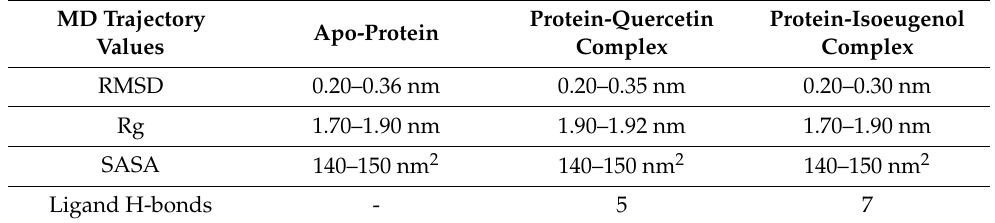
Figure 7. Analysis of RMSD, RMSF, Rg, SASA, and the number of hydrogen bonds of isoeugenol- (purple) and quercetin- bound (red) HAR complexes, as well as apo-protein α -glucosidase (green), at 100 ns. ( A ) Time evolution of RMSD values of both the complexes, along with the protein. ( B ) RMSF. ( C ) Radius of gyration (Rg). ( D ) SASA. ( E ) Hydrogen bonds. Table 6. MD trajectory values of isoeugenol and quercetin complexed with HAR.